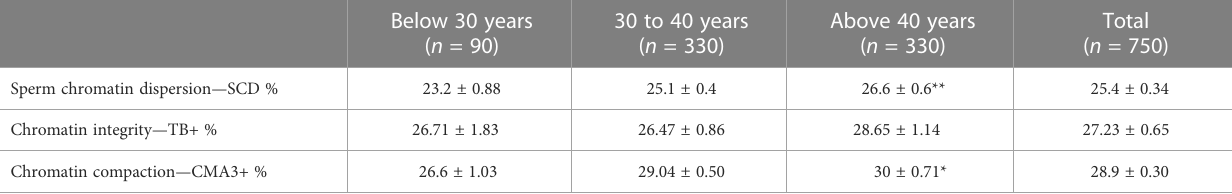
TABLE 3 Male age in fl uence sperm chromatin dispersion (SCD), chromatin integrity (TB+), and chromatin compaction (CMA3+) in studied